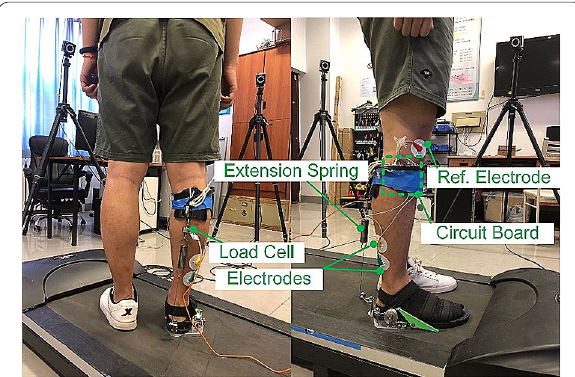
Figure 6 Walking trials and the sensors used to record biological and mechanical